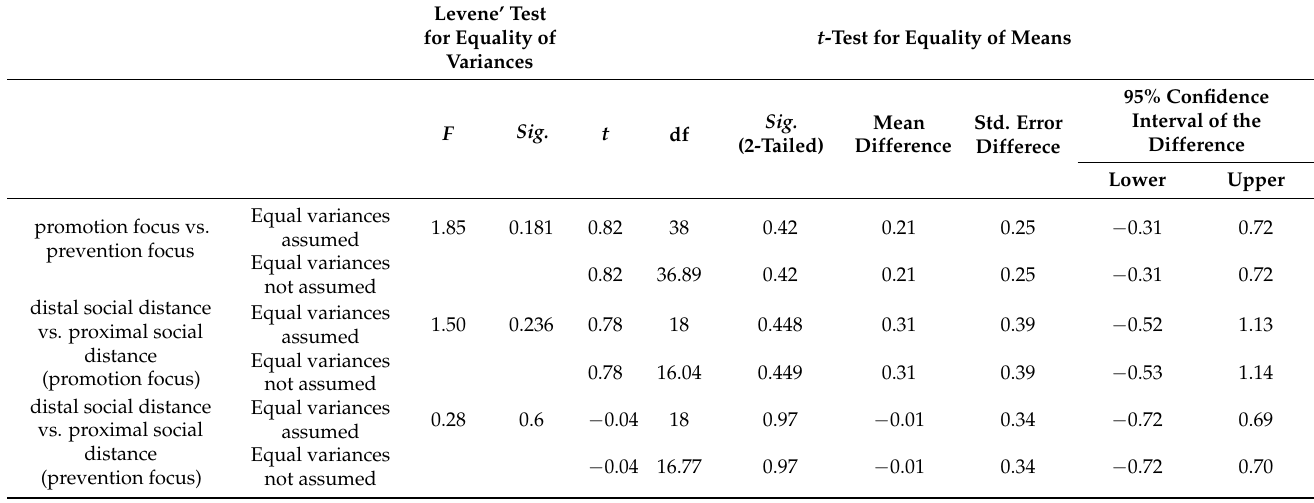
Table 1. Independent samples test (pre-experimental willingness to accept information). Levene’ Test for Equality of Variances